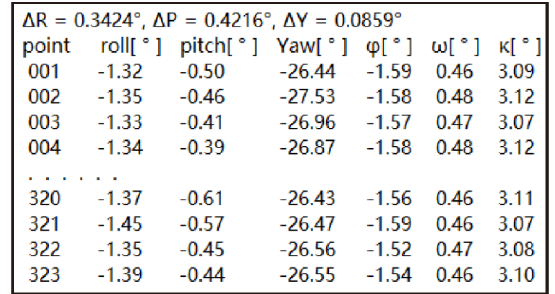
Figure 11. OPK obtained after YPR